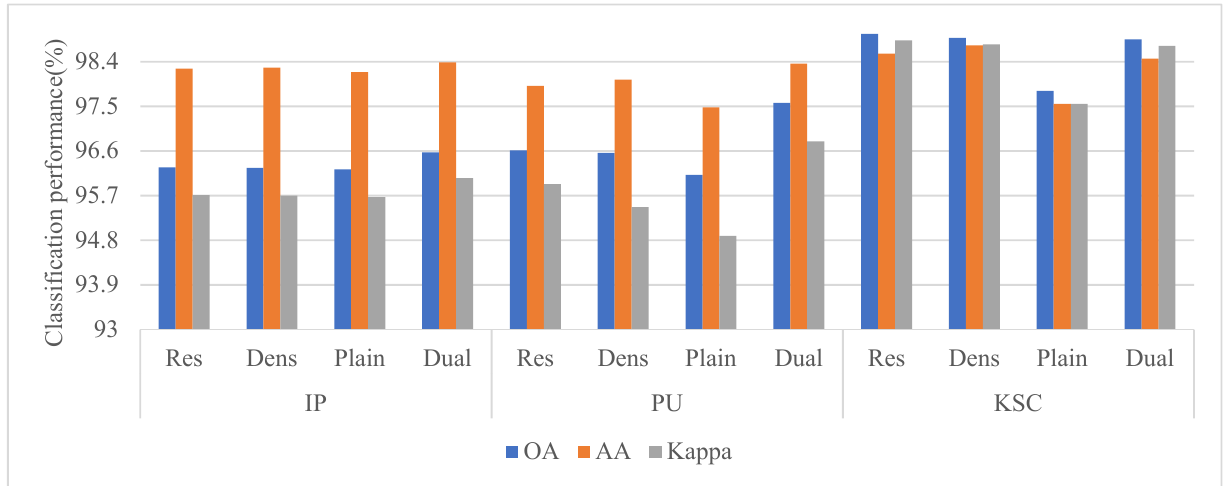
Figure 11. Classification performance of the classification network with the different feature learning path.